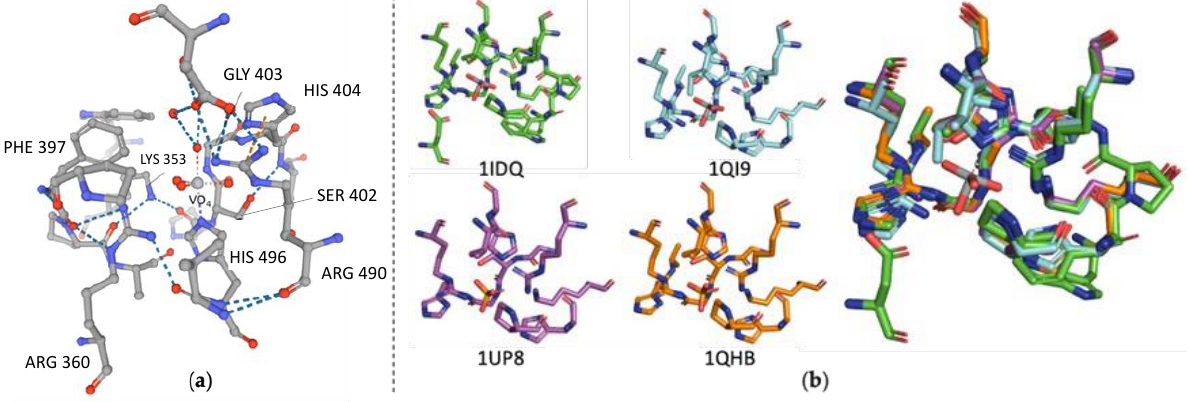
Figure 7. ( a ) Vanadate (VO 43 − )-binding pocket in vCPO from Curvularia inaequalis (PDB ID: 1IDQ). ( b ) Structural overlay of active sites from different vHPOs crystallized: vCPO from C. inaequalis (PDB ID: 1IDQ), vHPO from A. nodosum (PDB ID: 1QI9), vBPO from C. pilulifera (PDB ID: 1UP8), and vBPO from C. officinalis (PDB ID: 1QHB).